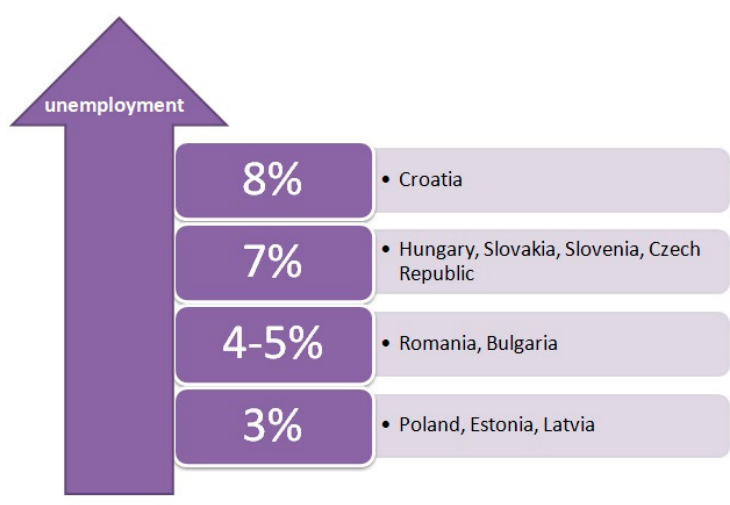
Figure 4. The unemployment rate in 2020 [20–23].